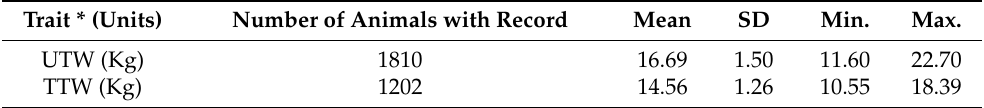
Table 1. Descriptive statistics for carcass quality and measured carcass traits on entire population. Trait * (Units) Number of Animals with Record